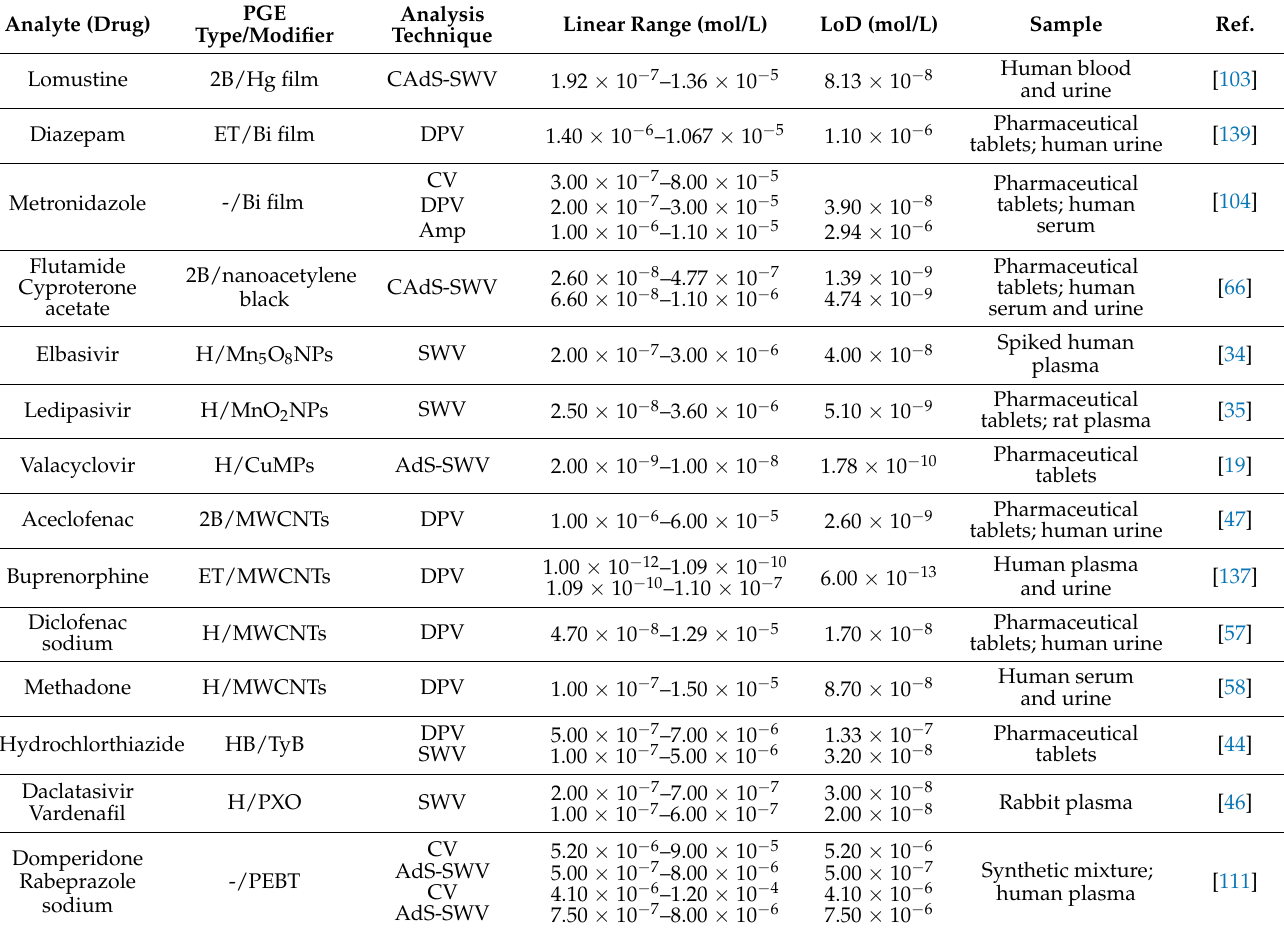
Table 3. The performance characteristics of voltametric methods developed for drug quantitative determination at (electro)chemically modified